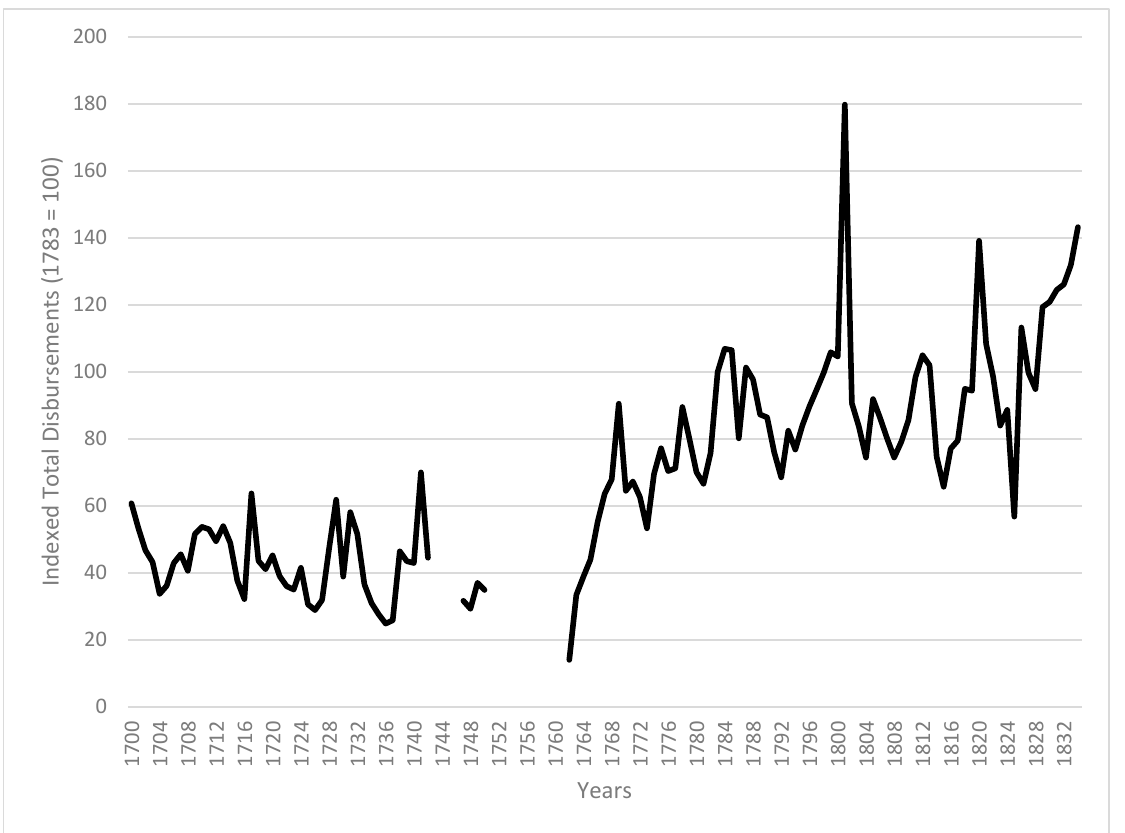
Figure 1. Total Overseers’ Disbursements in Butleigh, Somerset, 1700–1835: at constant (£1860–1869) Prices Indexed Where 1783 = 100. (see Clark 2007)